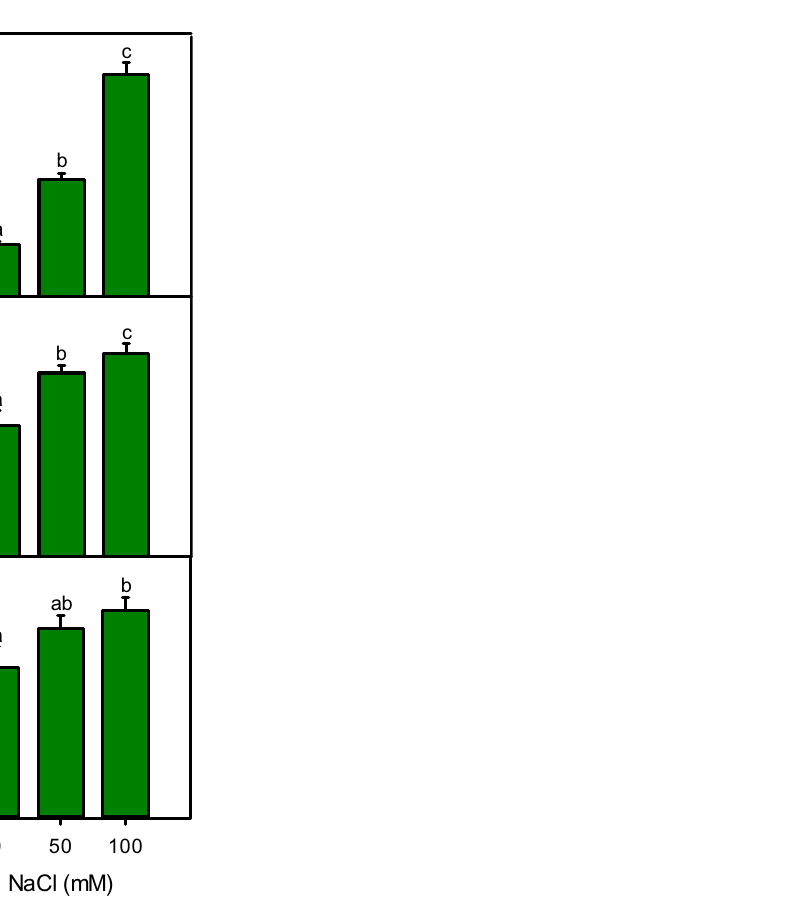
Figure 8. Damage markers including H 2 O 2 , MDA, and electrolyte leakage of Moringa oleifera under different salinity treatments. Different letters indicate significant differences at P <